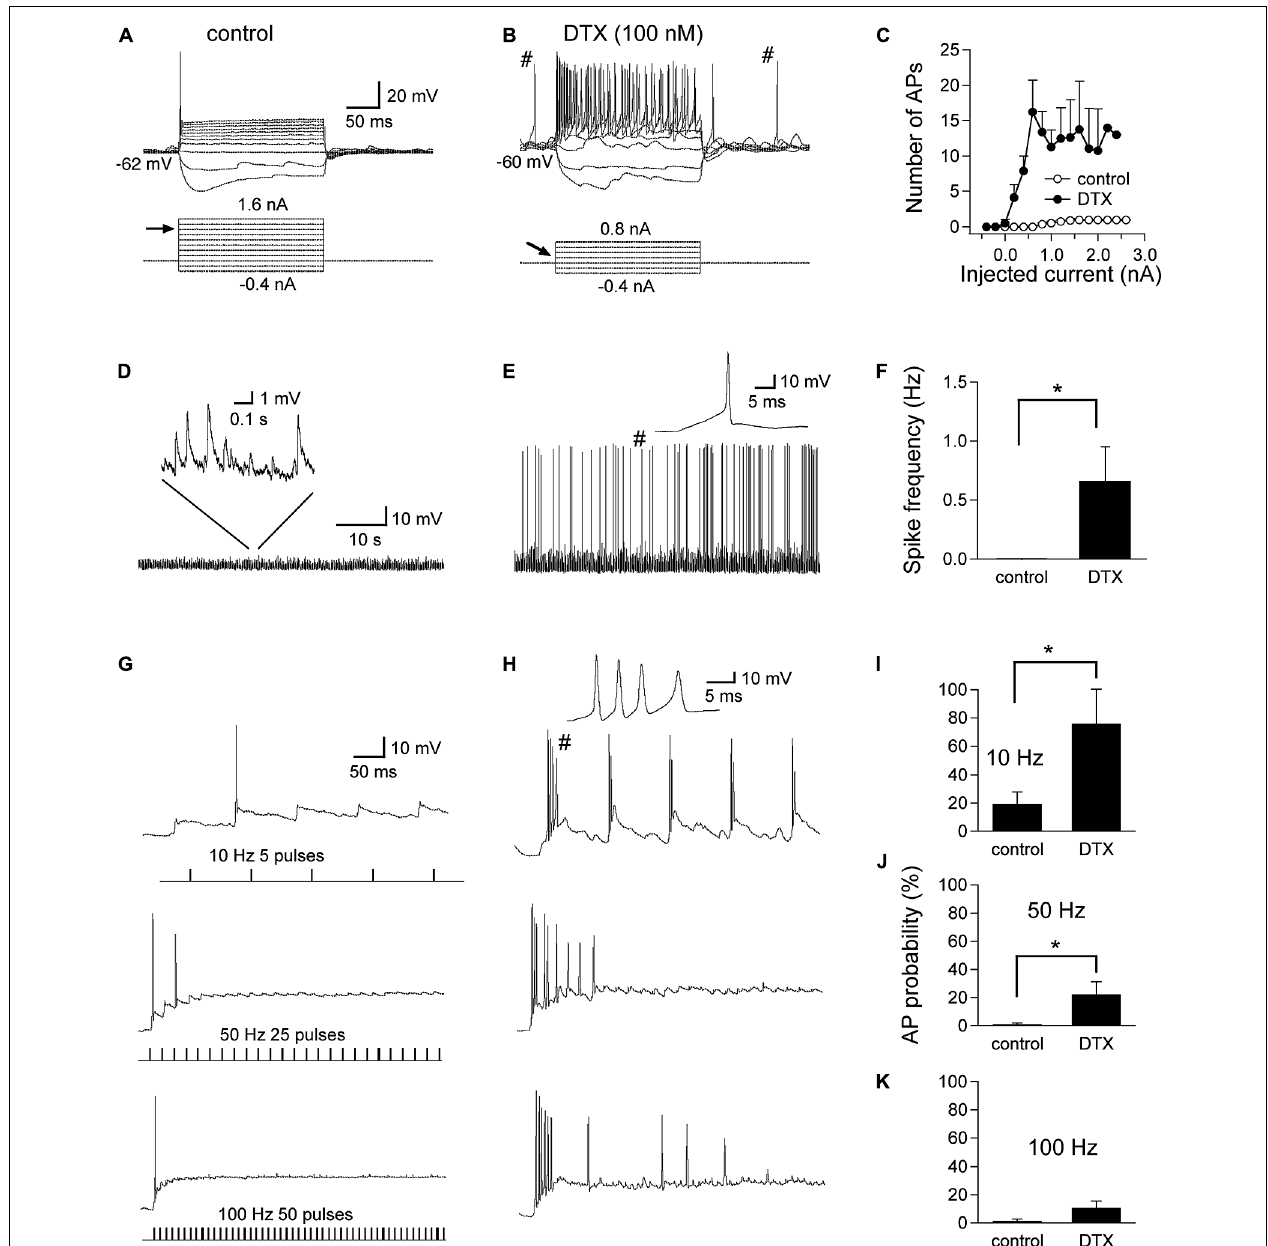
to several millivolts, without spike activity. (E) DTX increased the amplitude of sIPSP and transforms some into spikes (one spike indicated by # is shown at an enlarged time scale). (F) Spike frequency was significantly higher after DTX application than in control conditions ( n = 9). (G,H) Train stimulations at different frequencies were applied to evoke GABA responses. At 50 and 100 Hz, IPSPs summate, forming a sustained membrane depolarization of about 15 mV. GABA-induced spikes were seen occasionally. Under DTX, more spikes were seen at all three frequencies tested, and bursts of spikes are noted (a burst of four APs shown at an enlarged time scale). (I–K) Significant increase in AP probability was detected for the stimulations at frequency of 10 and 50 Hz but not 100 Hz ( n = 9). * p <